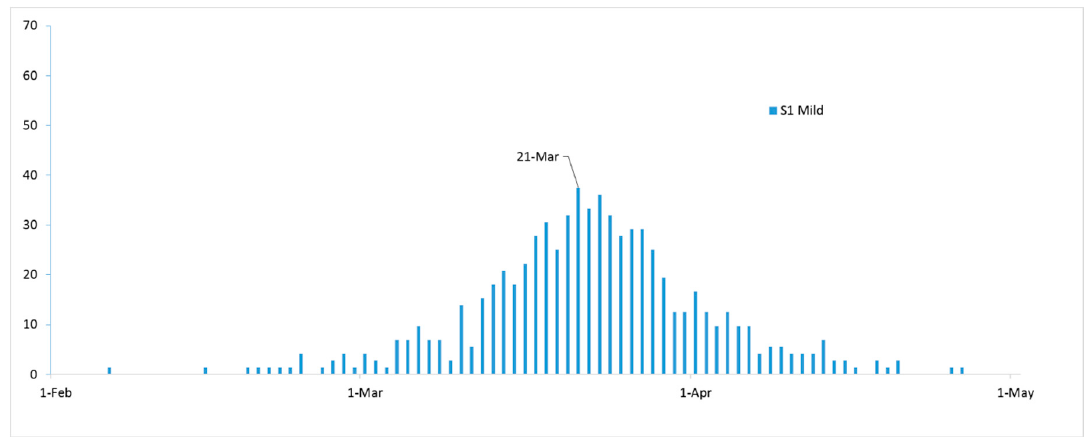
Figure 2. Simulated number of daily new COVID-19 cases in the mild compartmental state under scenario 1 (S1).